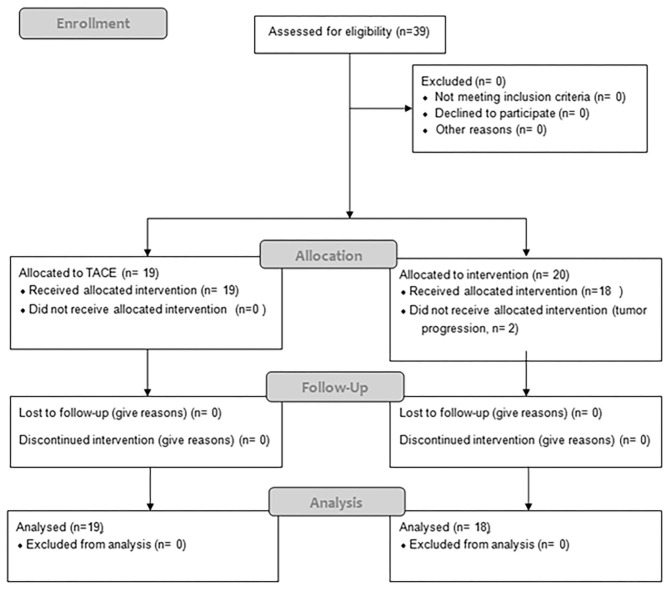
Consort diagram.